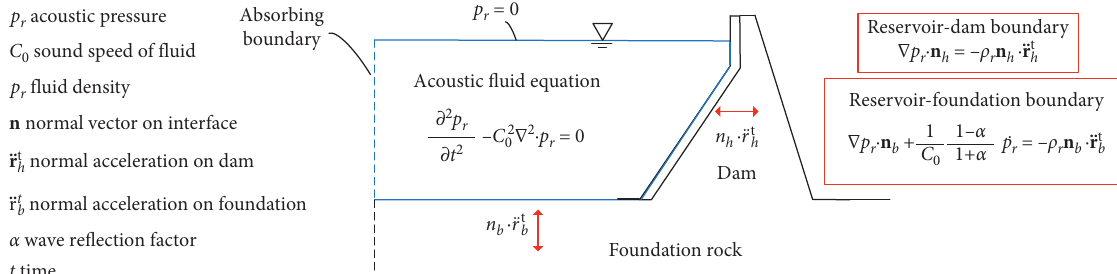
Figure 1: Schematic view of the dam-rock-reservoir FE model, highlighting the different conditions at the reservoir